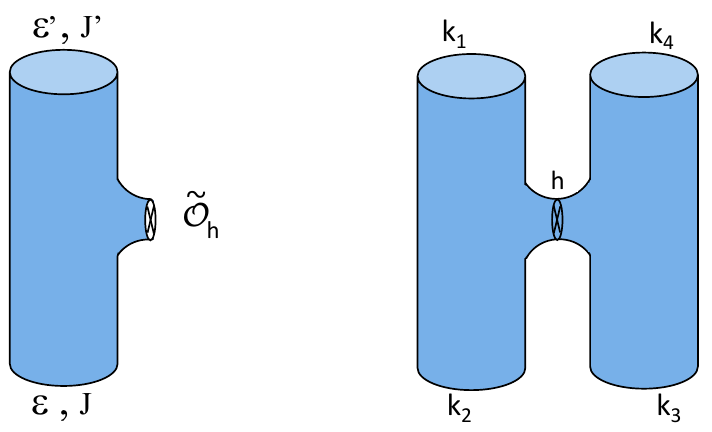
Figure 2 . The local operator e O h in the deformed theory creates a (cid:12)nite size cross cap. The matrix element between energy-momentum eigenstates can be computed by mapping to the Schottky dou- ble. The energy and momentum are encoded via four target space momenta given in equation